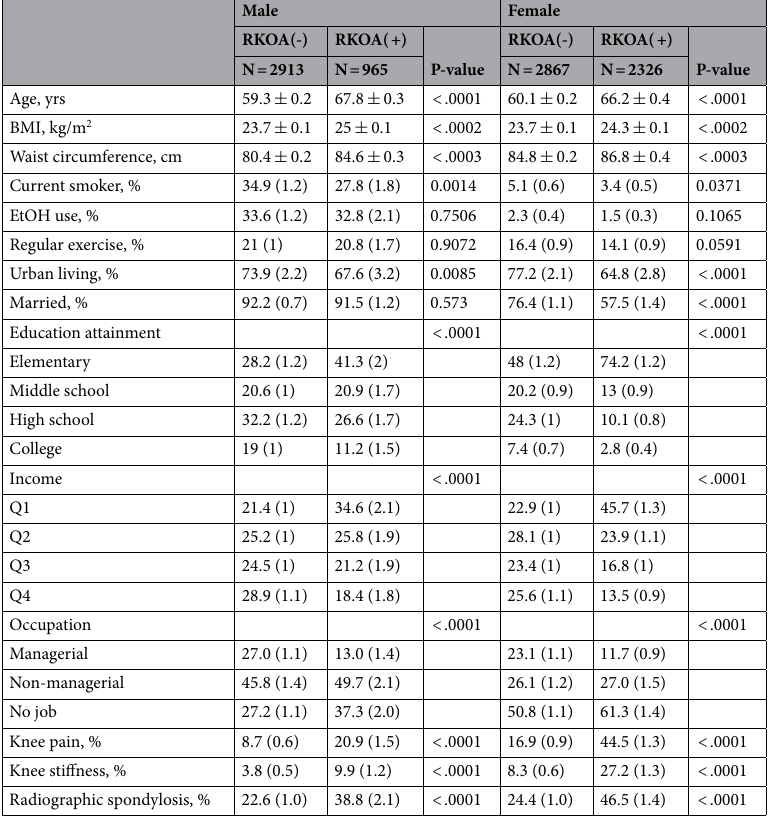
Table 1. Table 1. Subject characteristics. Numbers are Mean ± SE or Mean% (SE). BMI, body mass index; EtOH, ethanol; RKOA, radiographic knee